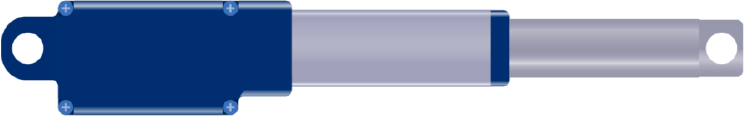
Figure 3. Core linear actuator of hand rehabilitation robot.